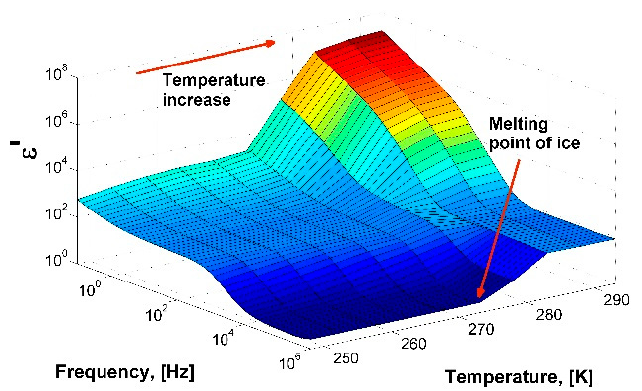
Figure 1. A 3D-diagram of the real part of dielectric spectrum of ice/water in the temperature range from 253 to 293 K.